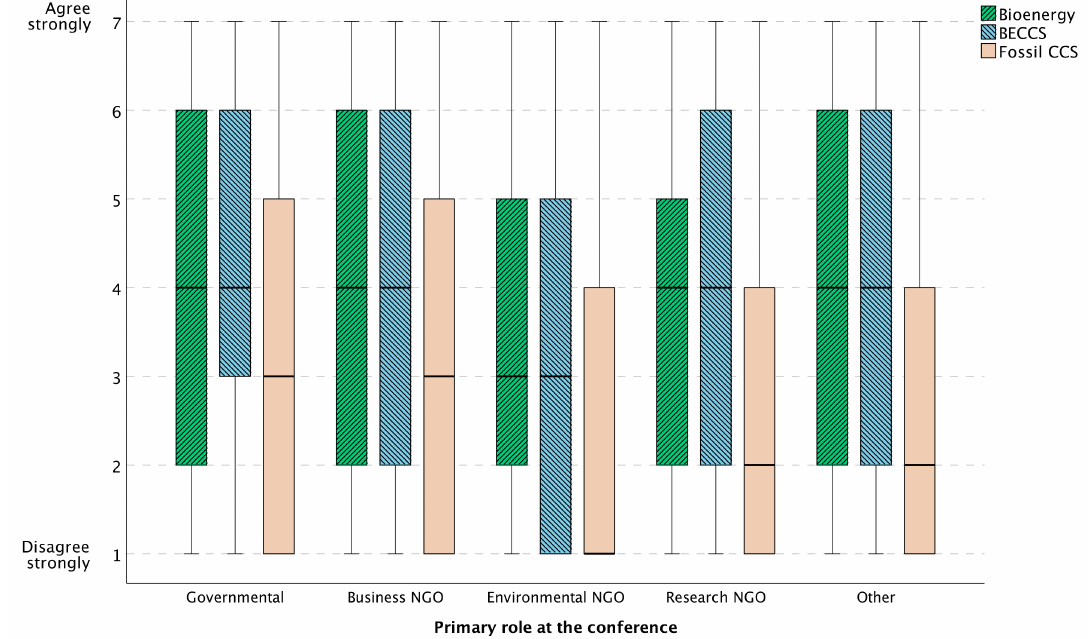
Figure 5. Responses on the importance of investing in bioenergy without CCS, BECCS or fossil CCS among different actor-types at the UNFCCC COPs” (including, but not limited to, delegates attending